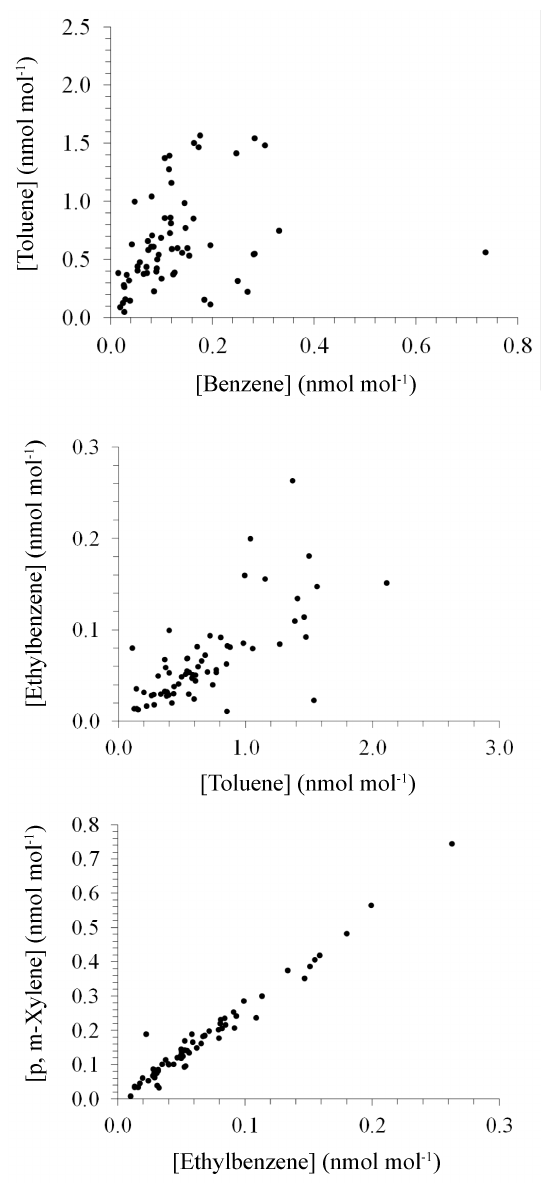
Figure 2. Example plots for the dependence between mixing ratios for different VOC